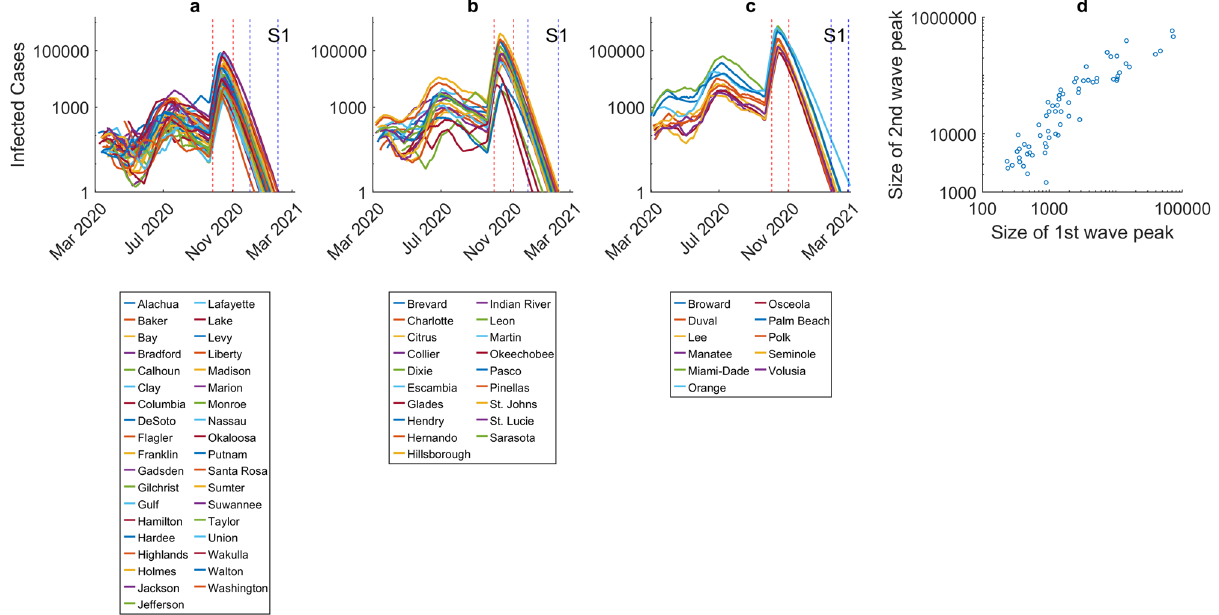
Figure 2. Epidemic forecasts for individual counties in the scenario where all interventions are lifted following the initial lockdown (S1). Each curve represents the median prediction for a given county. The results are stratified by initial incidence growth rate in each county (Group a < 0.05, Group b > 0.05– 0.15, Group c > 0.15). The intervention scenario (also see Supplementary Fig. S3) represents a full release of lockdown and social distancing from October 1st. The y-axis is shown in log-scale to better visualize the difference between the size of the first and second epidemic waves. The range of epidemic peaks and epidemic ending dates for each group is shown by red and blue dotted vertical lines, respectively. The 2nd wave peaks of infected cases occurs between September 27th–November 2nd for Group a, October 3rd–November 7th for group b, and October 3rd– November 2nd for Group c. The epidemic ending dates occur between December 2nd–January 21st, 2021 for Group a, December 2nd–January 25th, 2021 for group b, and January 16th, 2021–March 2nd, 2021 for Group c,